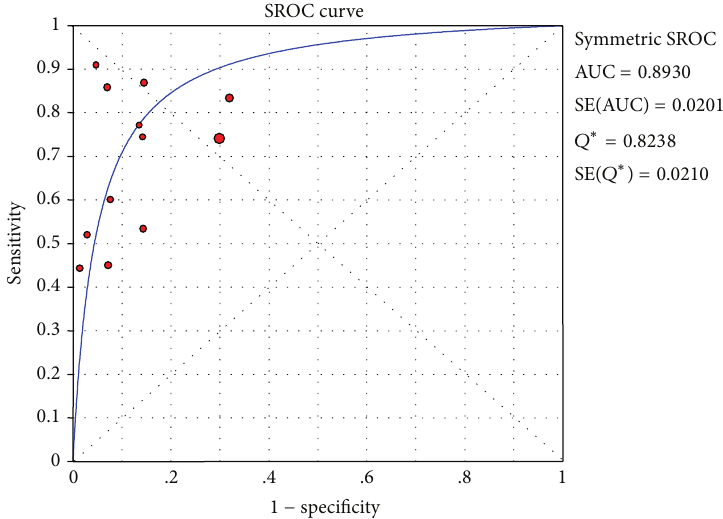
Figure 4: SROC of the 12 included studies.